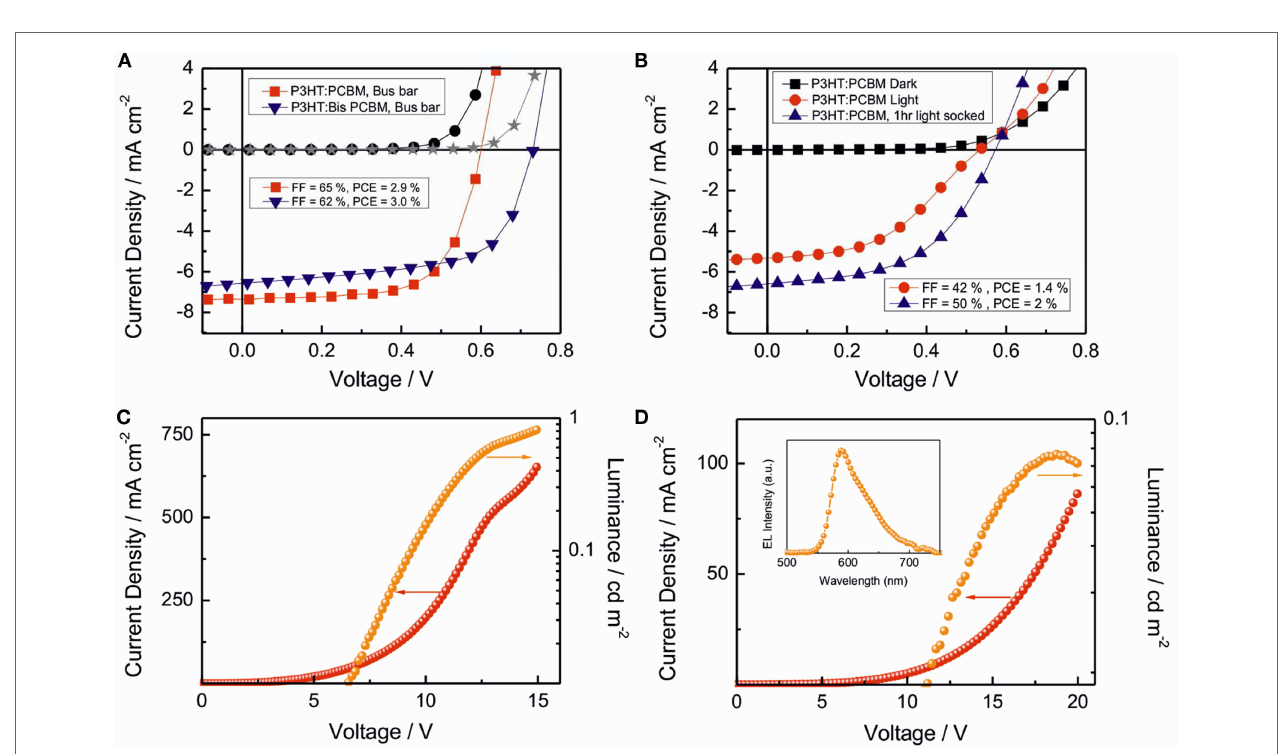
FigUre 7 | J–V characteristics of the OPVs: (a) glass/PeDOT:Pss/Pei/P3hT:PcBM or bis-PcBM/MoO x /ag, and (B) glass/PeDOT:Pss/Pei/ P3hT:PcBM/PeDOT:Pss/ag; l–J–V characteristics of OleDs: (c) glass/PeDOT:Pss/Pei/aDs200re/MoO x /ag, and (D) glass/PeDOT:Pss/Pei/ aDs200re/PeDOT:Pss/ag. The inset in (D) displays the el spectrum of corresponding OleDs